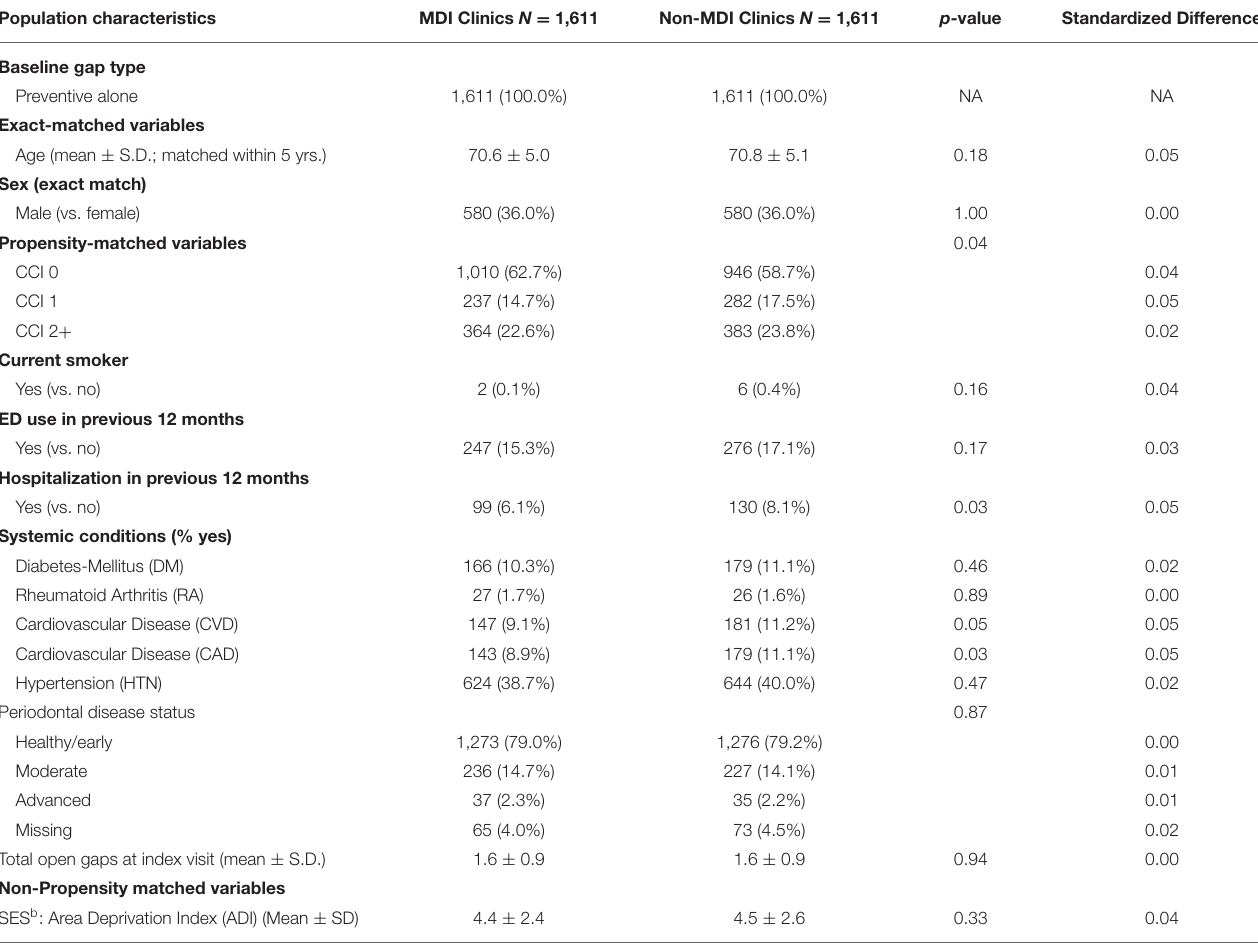
TABLE 1.1 | Population Characteristics: Preventive Care Gaps Only. Population